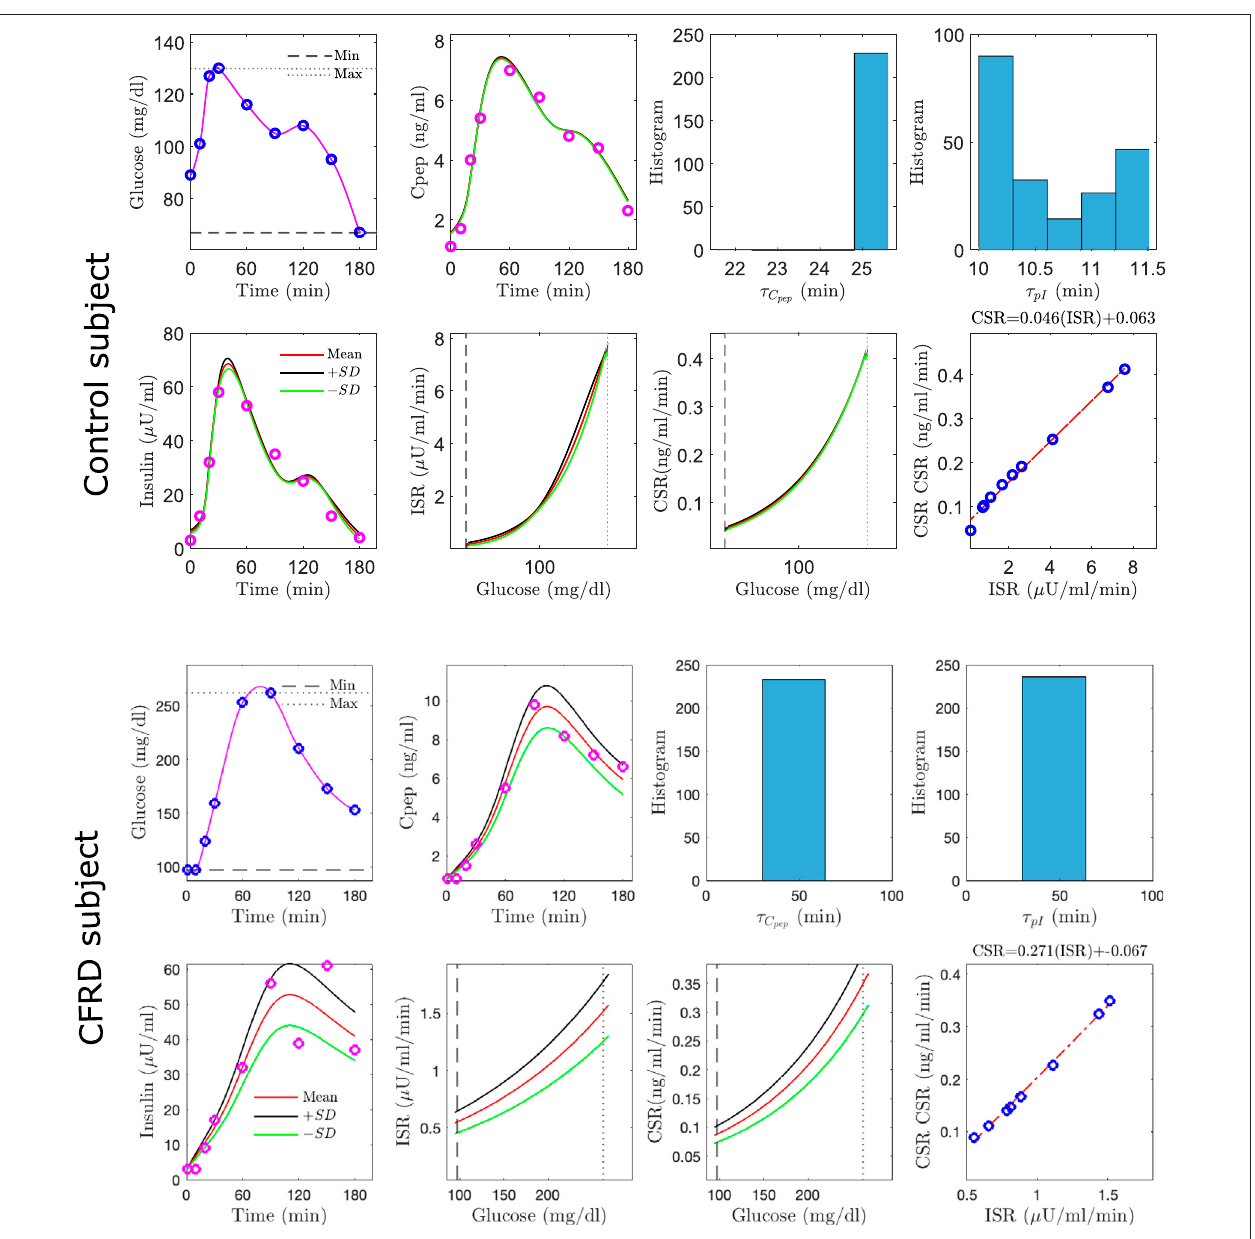
FIGURE 4 | Estimation results, using the algorithm with the single compartment model, for a single control (Top) and a single CFDR (Bottom) subject. Each composite includes (A) glucose measurements (blue circles) and the interpolated glucose (magenta line) used as model input (B) measured c-peptide (circles) and model-generated mean c-peptide (magenta line) and ±standard deviation (black, green lines); histograms of inferred degradation time for c-peptide (C) and insulin (D) ; (E) measured insulin (red circles) and estimated insulin trajectory (magenta with ±SD black, green); mean inferred ISR (F) and CSR (G) (red with SD black, green); and (H) CSR/ISR